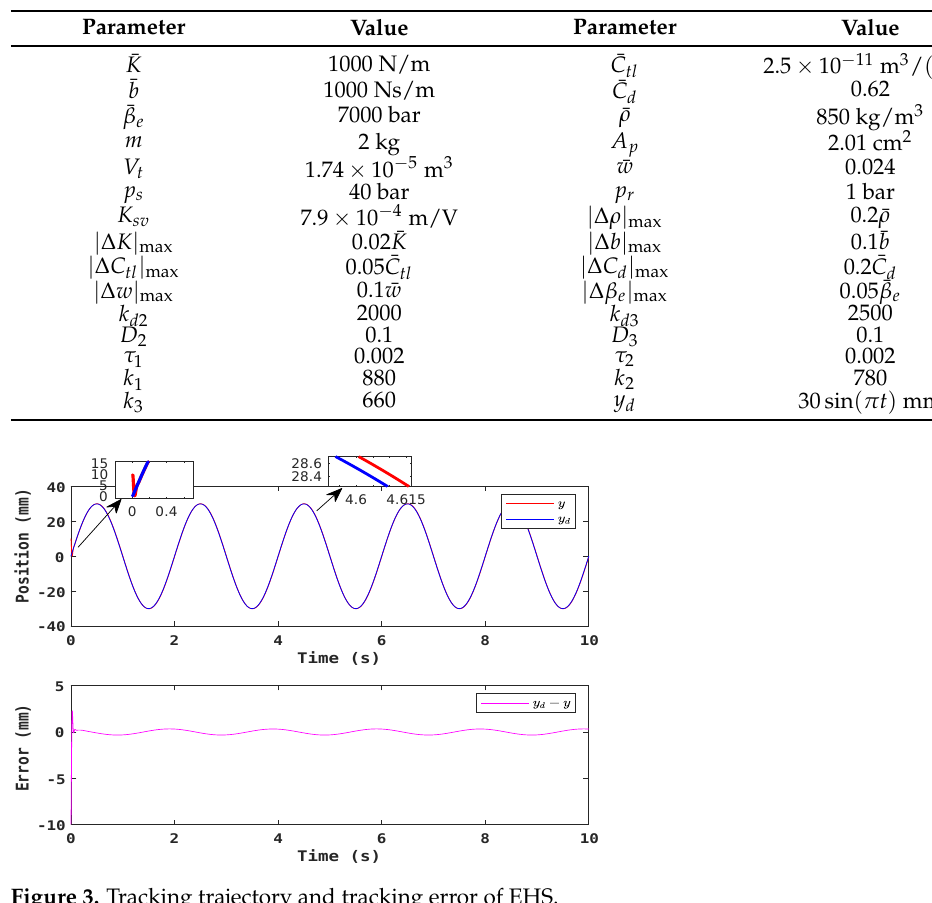
Figure 3. Tracking trajectory and tracking error of EHS.